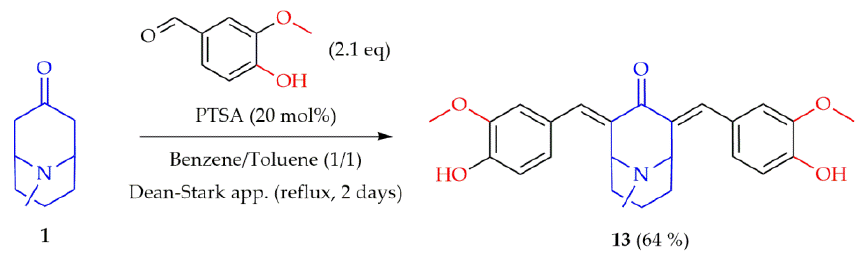
Scheme 8. Synthesis of compound 13 containing free -OH